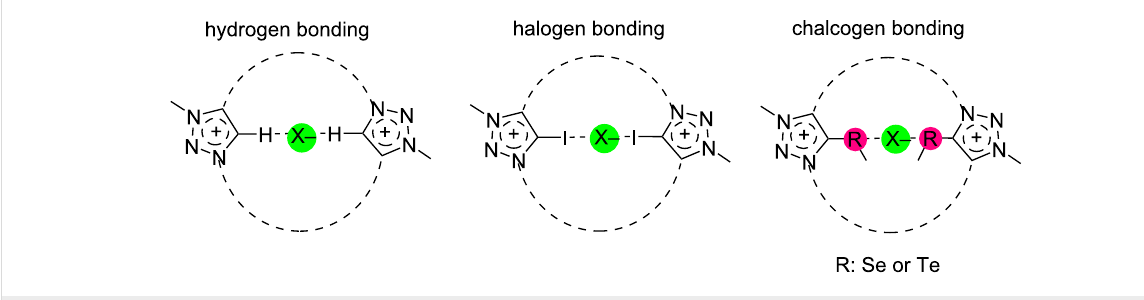
Figure 1: Hydrogen, halogen or chalcogen bonding to anions within a bistriazolium macrocycle.